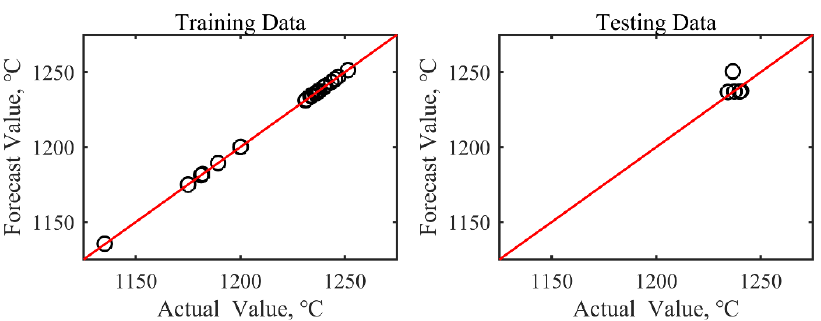
Figure 9. Actual value and forecast value of T sp 5.